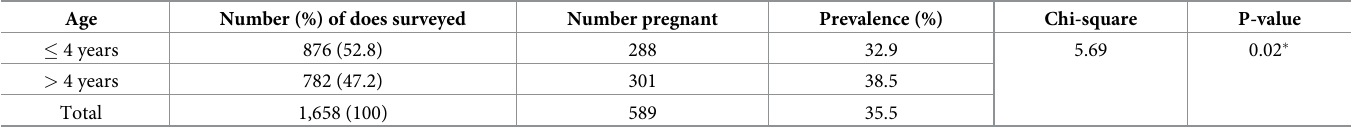
Table 1. Age distributions and pregnancy status of female goats slaughtered for meat in Enugu, Nigeria. Age Number (%) of does surveyed Number pregnant Prevalence (%)